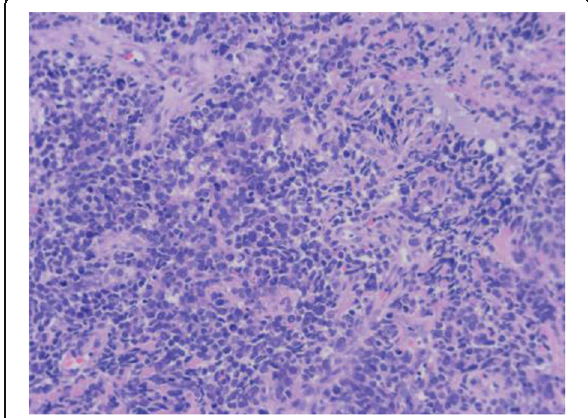
Fig. 1 The tumor tissue is separated by fibrovascular vessels to form an epithelial patchy-like structure